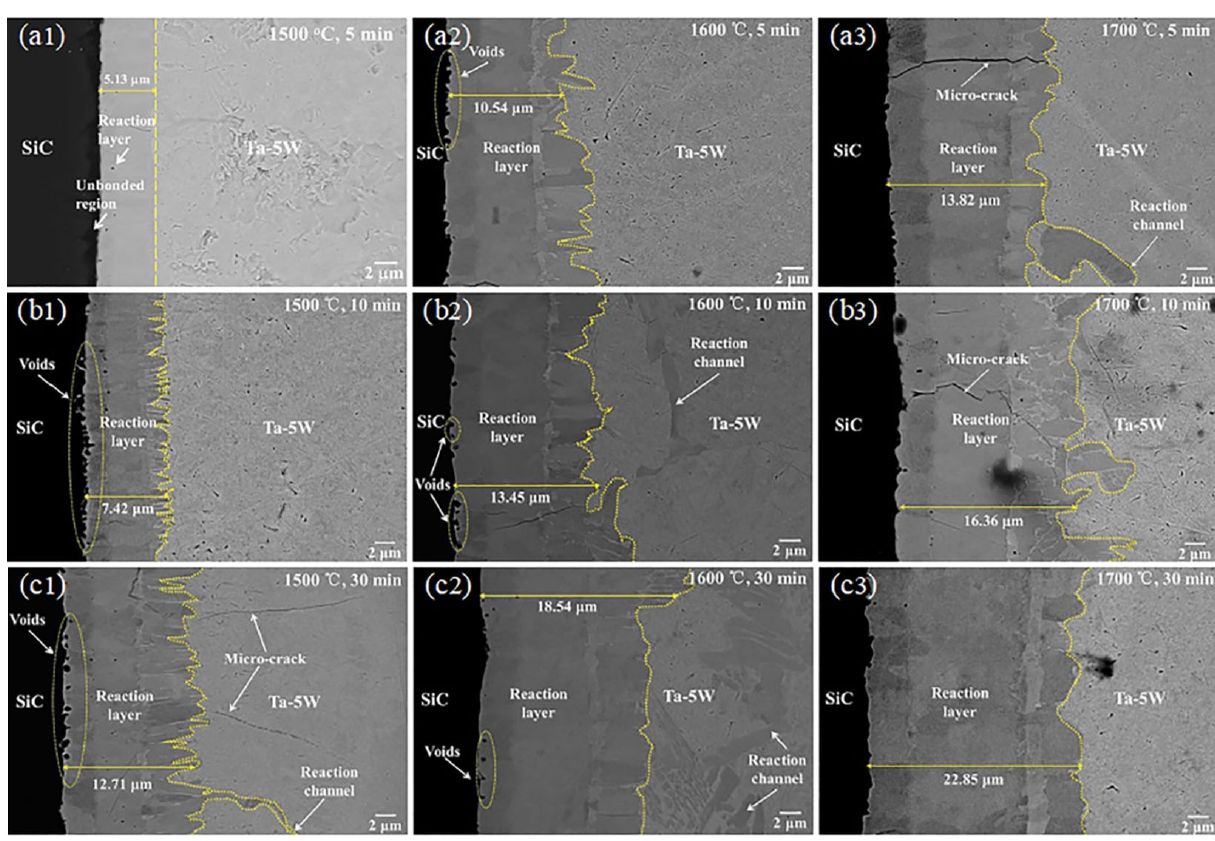
Fig. 7 BSE micrographs of SiC/Ta–5W interface in the SiC/SiC joints diffusion-bonded at (a1–c1) 1500 ℃ , (a2–c2) 1600 ℃ , and (a3–c3) 1700 ℃ for 5, 10, and 30 min, respectively, showing the interfacial microstructural evolution. Reproduced with permission from Ref. [72], © Elsevier Ltd and Techna Group S.r.l. 2017.